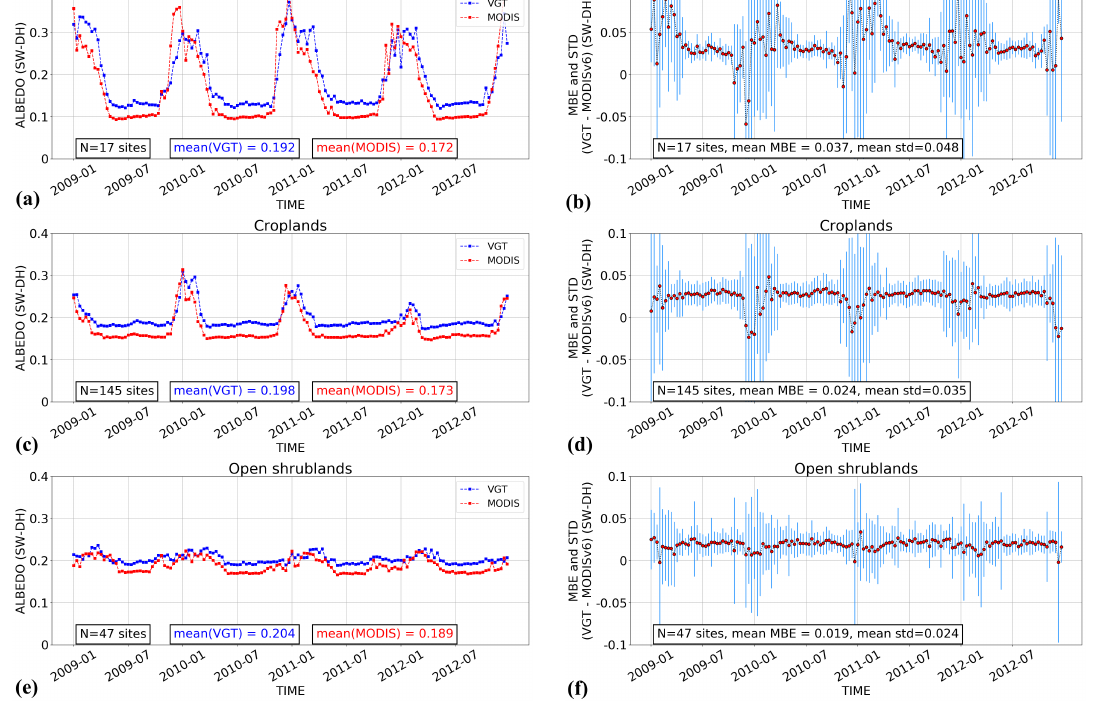
Figure 8. Time series of VGT versus MODIS for specific land covers. We calculated the average of the surface albedo for both satellite products and the MBE and STD of the differences for ( a , b ) Evergreen needleleaf forest, ( c , d ) Croplands and ( e , f ) Open shrublands over a collection of sites (chosen from the Aerosol Robotic Network, AERONET). The number of sites used per land cover type is denoted by N. The mean value of the mean surface albedo for both satellite products over the period 2009–2012 is given (left-hand-side figures). The mean MBE and the mean standard deviation (STD) of the differences between the two products are also given (right-hand-side